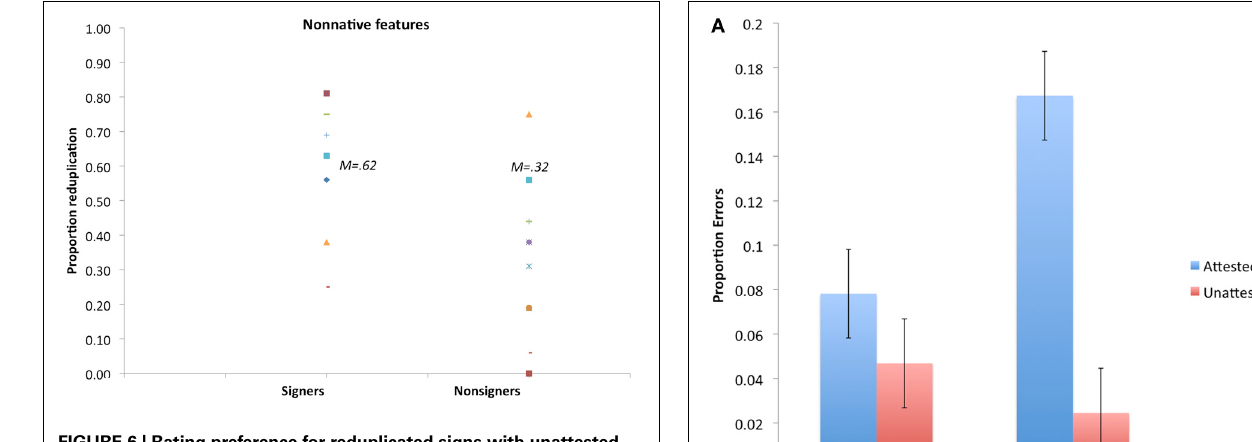
FIGURE 6 | Rating preference for reduplicated signs with unattested handshapes in Experiment 3.